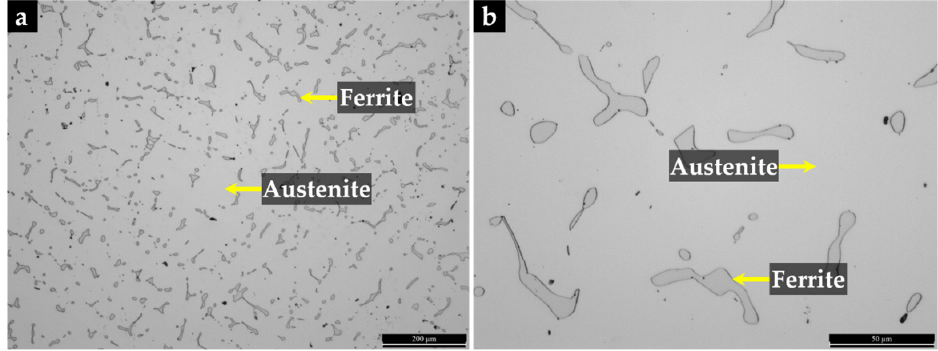
Figure 3. OM image of the austenitic stainless steel after solution heat treatment (1075 °C/2 h) ( a ), and at higher magnification ( b ). Microstructure revealed by etching with 10% oxalic acid.